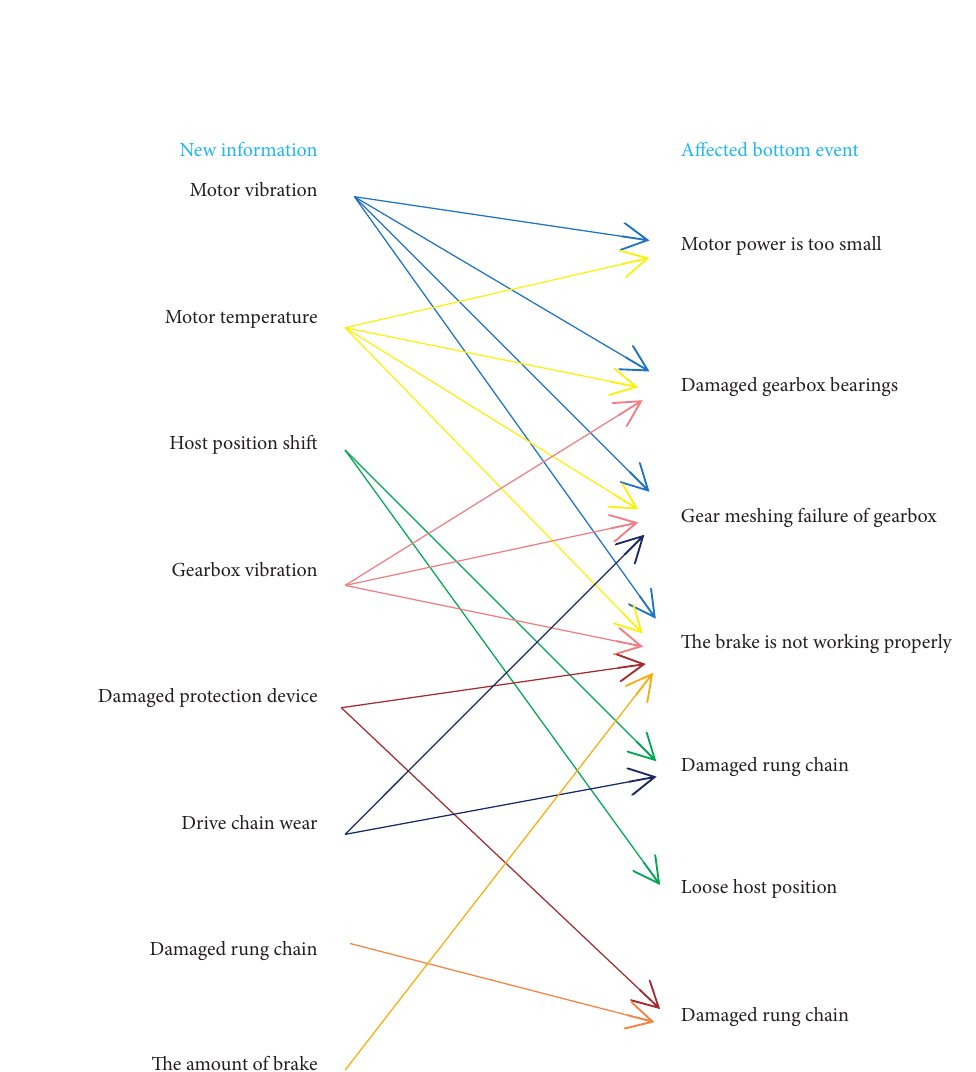
Figure 3: Bottom events affected by dynamic